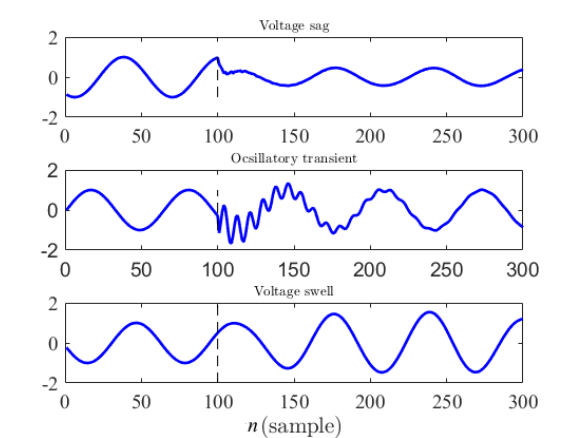
Figure 4. Voltage waveforms obtained from the circuits are shown in Figures 1–3. Disturbances start at sample